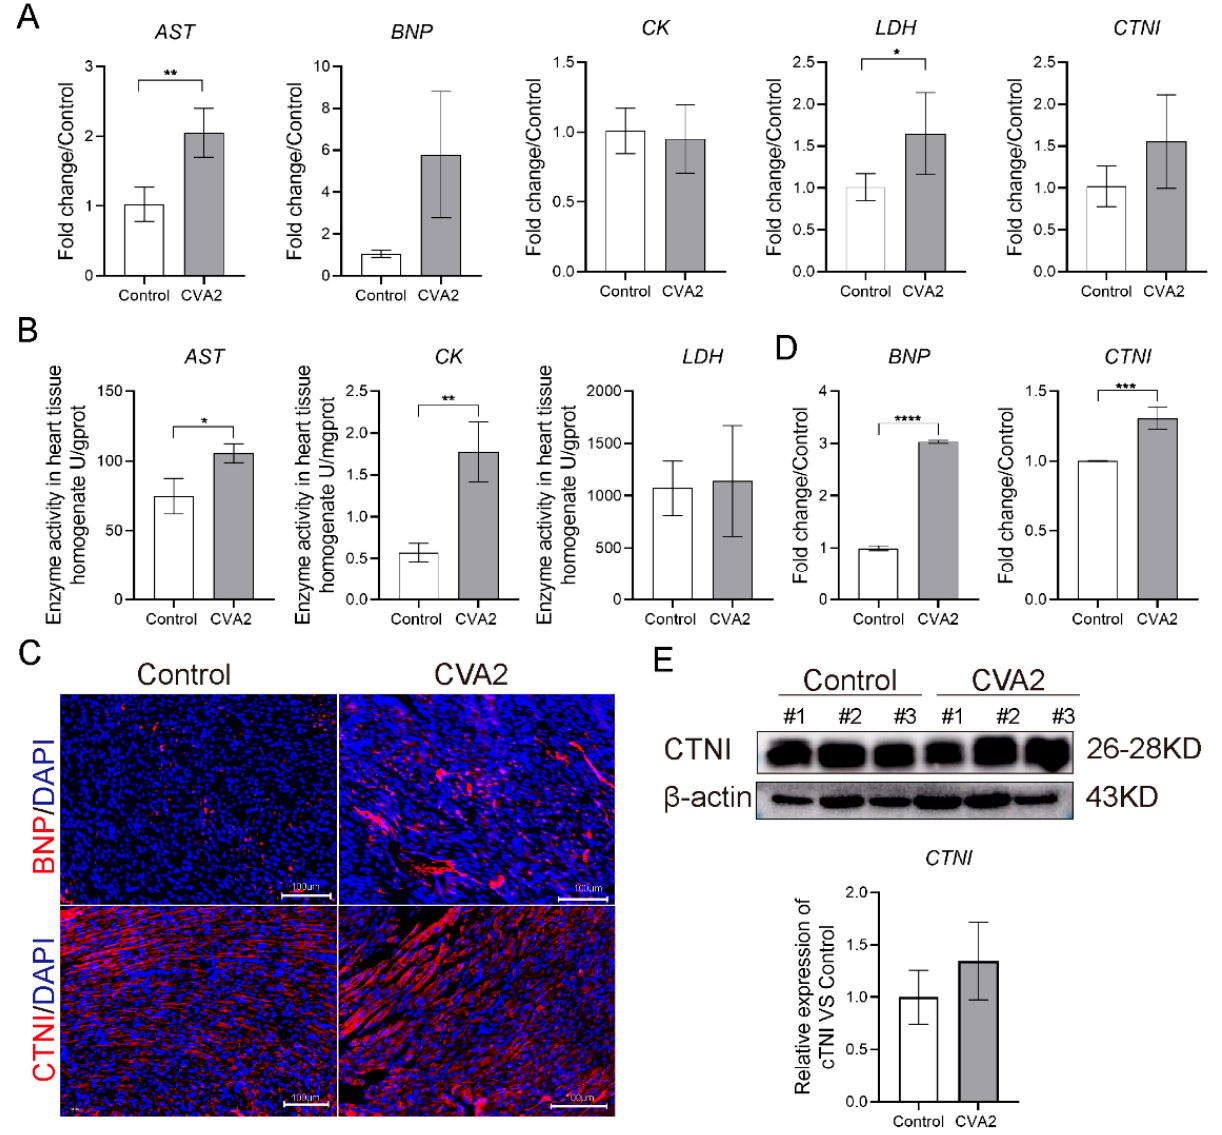
Figure 2. CVA2 infection increases the level of cardiac enzymes. ( A ) Quantification of mRNA levels of AST, BNP, CK, LDH and CTNI in the heart tissues at 7dpi ( n = 4 per group). ( B ) The activity of AST, CK and LDH in heart lysates at 7 dpi ( n = 6 per group). ( C ) Immunofluorescence staining of BNP and CTNI (red) in the heart slices ( n = 4 per group). ( D ) The fluorescence intensity of BNP and CTNI expression. ( E ) WB analysis of CTNI expression in heart tissues ( n = 3 per group). Each bar indicates mean ± SD. * p < 0.05, ** p < 0. 01, *** p < 0.001, **** p < 0.0001 vs. control.